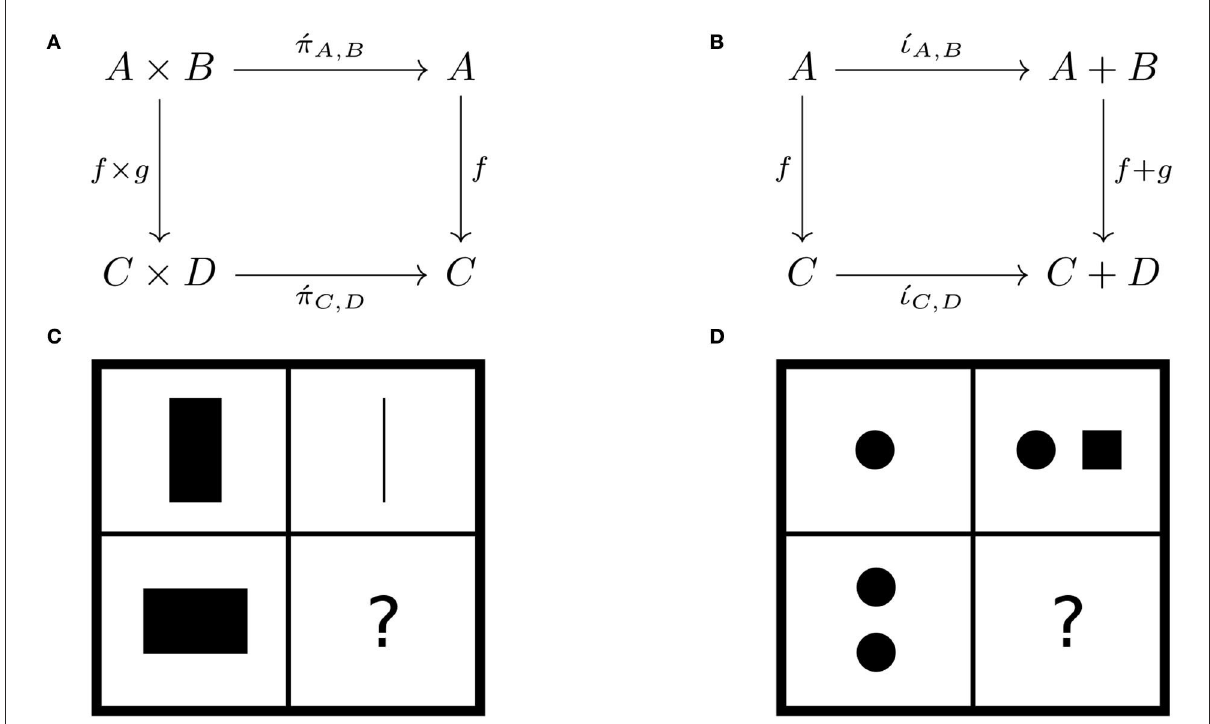
FIGURE8 Two natural transformations: (A) natural projection and (B) natural injection as progressive matrices (C,D) , respectively.